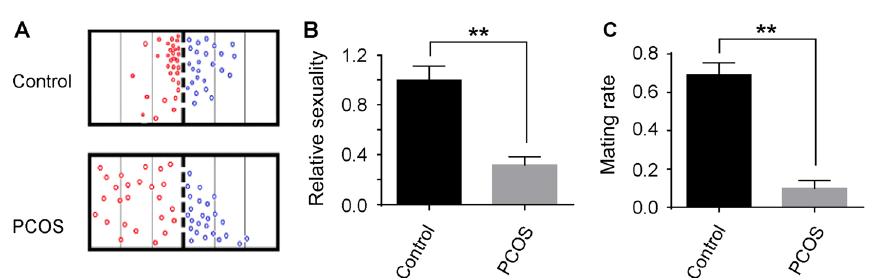
Figure 4. Swimming patterns, sexuality scores, and mating rates of control and PCOS zebrafish. ( A ) Static positions of control (top panel, red circles) and PCOS fish (bottom panel, red circles) at 15-s intervals during a 30-min recording period in the morning. Bold dashed lines indicate the net. In the control setting, the female showed preferences to swim in areas close to the net. In the experimental setting, the PCOS fish swam in all areas, either near or far from the net. Blue circles show the static positions of the male fish at 15-s intervals. ( B ) Sexuality scores of control females (black bar) and PCOS fish (grey bar). The sexuality levels of control fish were normalized to 1, and the sexuality levels of PCOS fish were compared to the base value of 1. Note the decrease in sexuality levels in PCOS fish. ( C ) Mating rates of control (black bar) and PCOS fish (grey bar). Note the decrease of mating in PCOS fish. Data represents the Means ± SE (n = 12 in each group). **p <